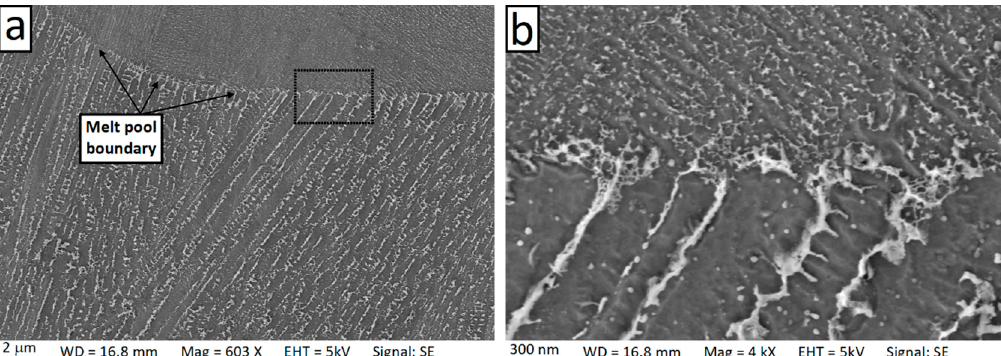
Figure 12. Scanning electron microscopy (SEM) micrograph of the vertical plane showing the change of the dendrite arm spacing and the growth direction when crossing a melt pool boundary. Panel ( b ) contains a higher magnification of the zone indicated by the dashed box in panel ( a ).